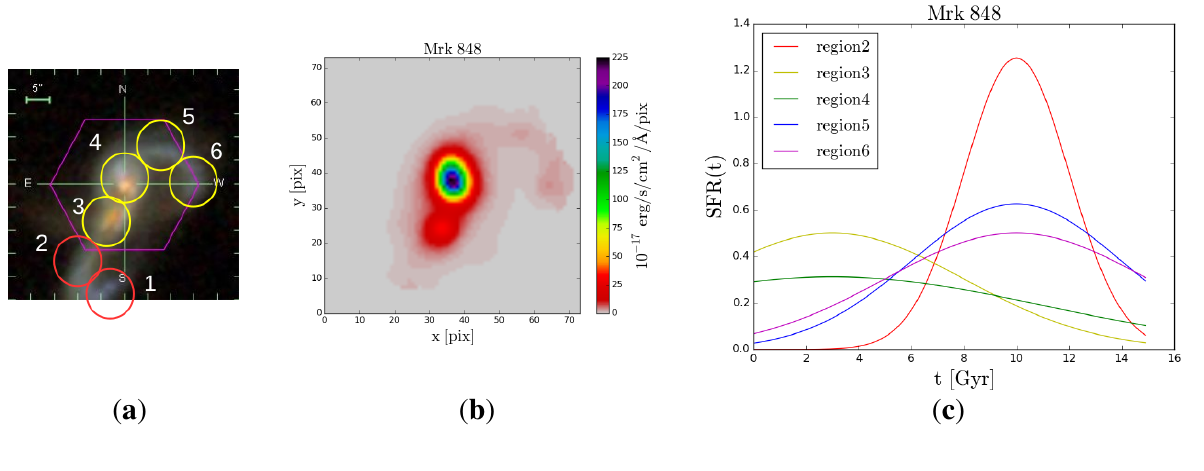
Figure 2. Interacting pair Mrk 848. ( a ) SDSS three-colour image of the object. Yellow circles correspond to the regions completely covered by the MaNGA IFU, meanwhile regions with red circles correspond to regions not covered or partially covered. ( b ) MaNGA H map of the galaxy merger. Flux units are per spatial pixel. ( c ) Estimated SFH for each α selected region in colour-code according to the